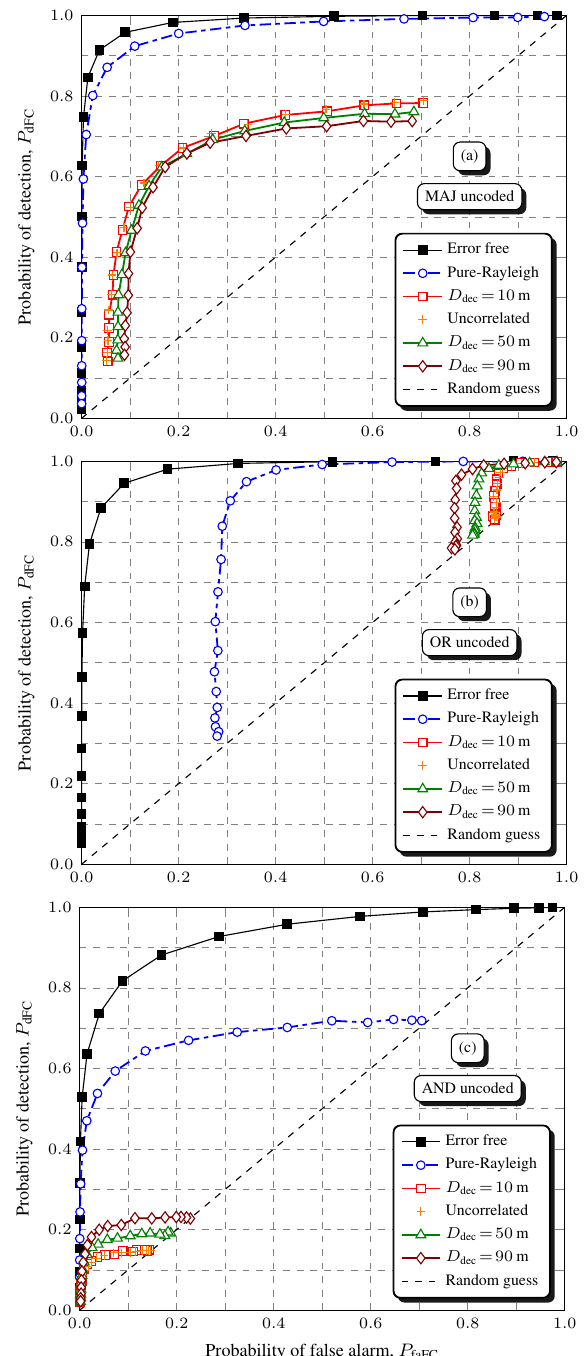
Figure 4. ROCs considering no channel coding applied to the report channel transmissions, for E b / N 0 = 6 dB, σ dB = 12.28 dB and L = 50 m: MAJ rule ( a ), OR rule ( b ), and AND rule ( c ). This figure is better viewed in